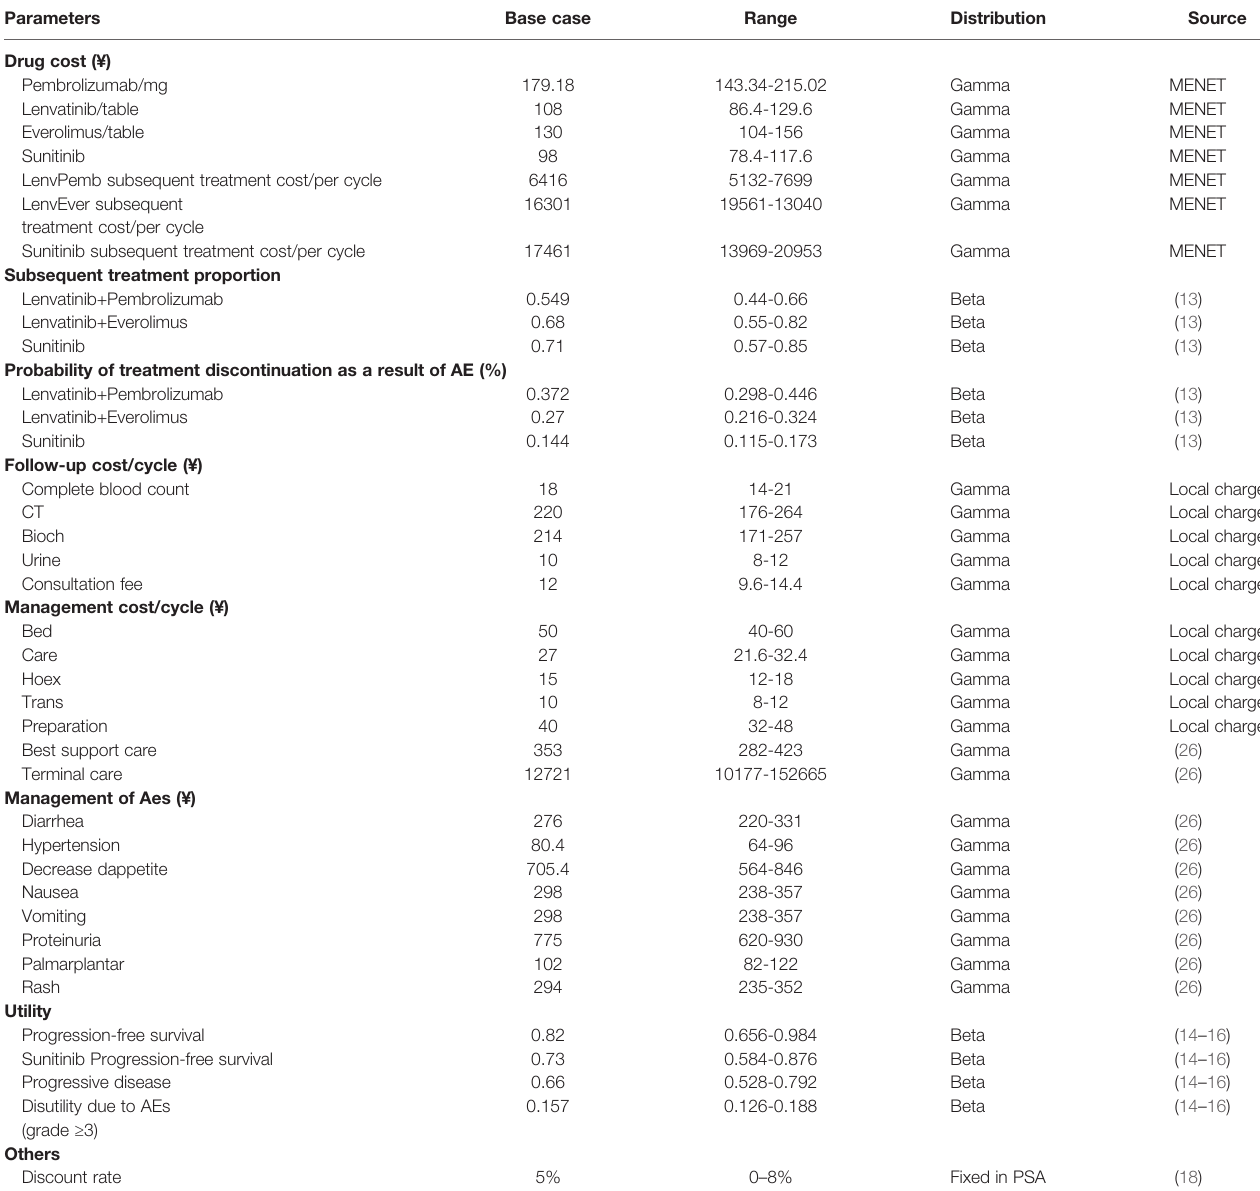
TABLE 1 | Summary of main medical costs, utility values, and other